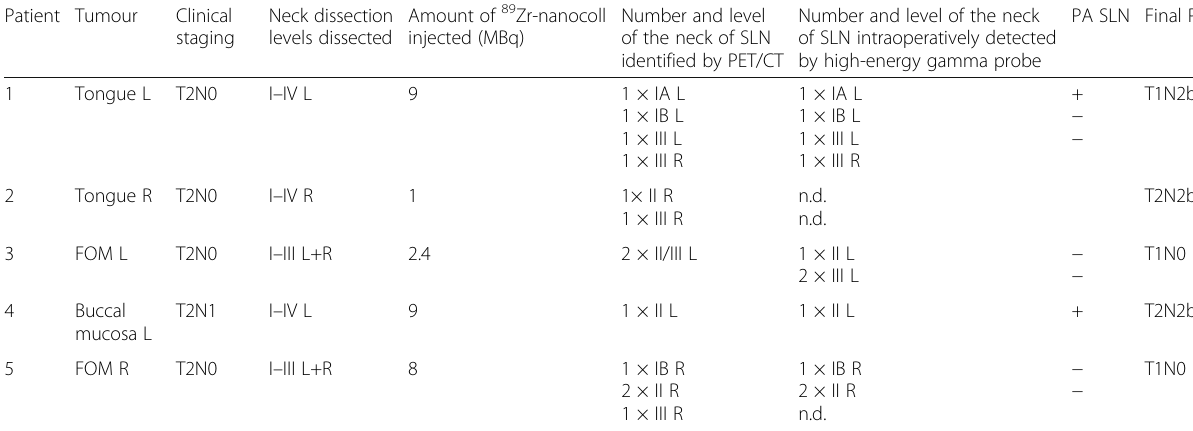
Table 1 Results of PET/CT imaging and SLN procedure Patient